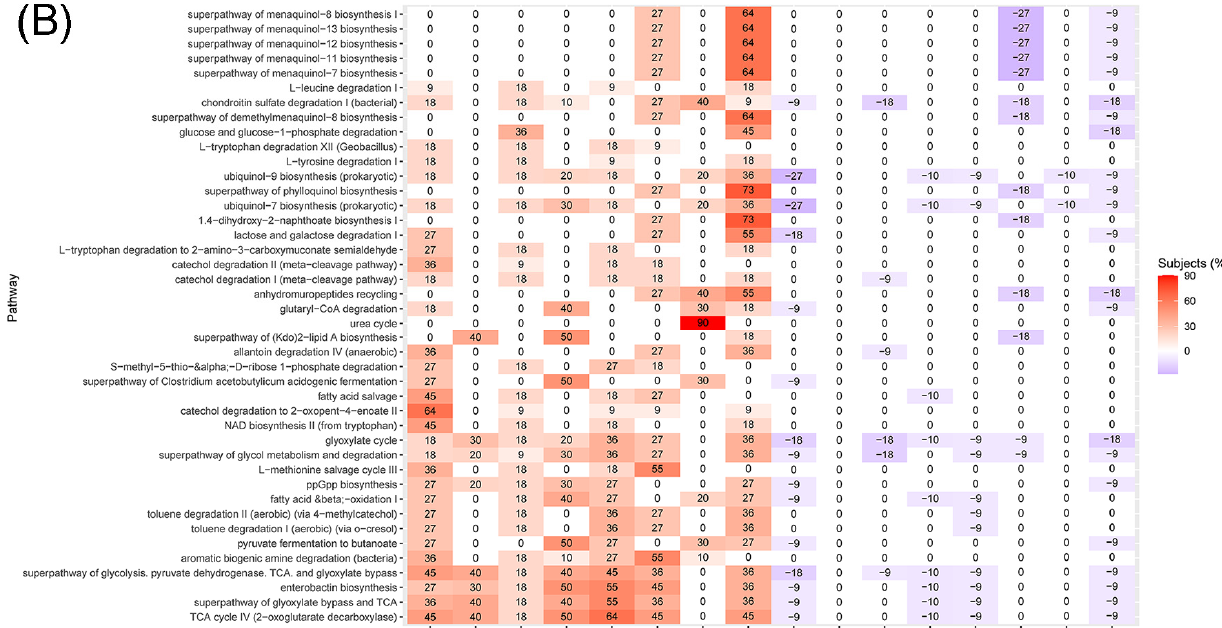
Figure 3. Heatmaps showing the percentages of subjects who had significantly increased (red) or decreased (blue) abundance of ( A ) genera and ( B ) metabolic pathways after prebiotics treatment when compared to blanks. Only the 40 genera (or pathways) that had the highest numbers of cases (subjects) showing significance in the differential abundance analysis are shown. To avoid noise, we used stricter criteria for pathways: only the cases that had centred log-ratio values between each treatment and the corresponding blank sample higher than 2 were included.